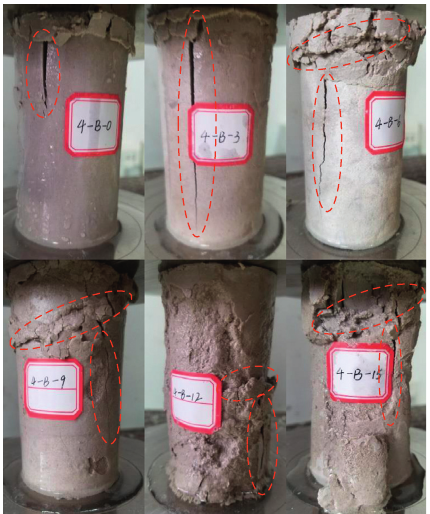
Figure 9: Failure morphology diagram of saturated specimens under different dry-wet cycles with a water-to-cement ratio of